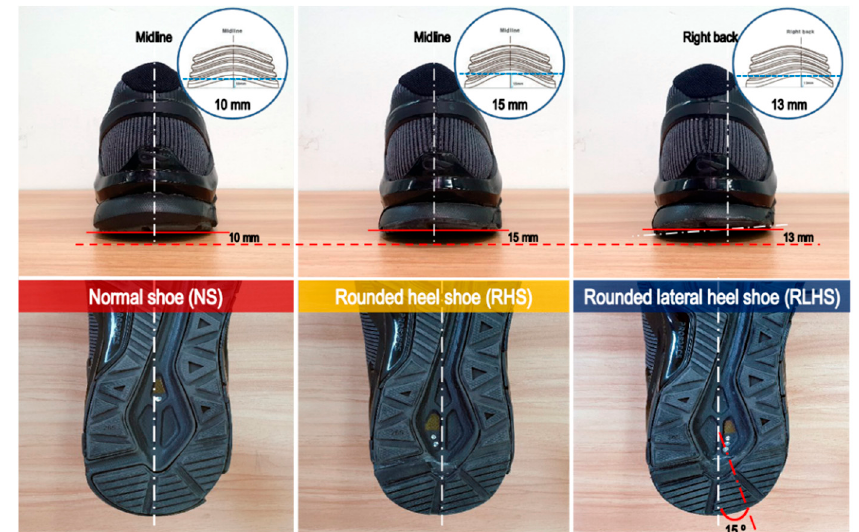
Figure 2. Rear view of the outsole of running shoes.